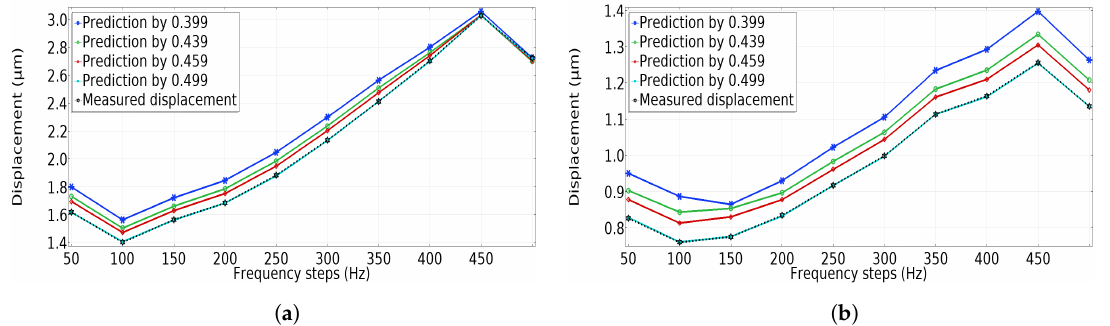
Figure 15. Displacement amplitude versus different Poisson’s ratios in the two boundary conditions; ( a ) connected pipette; ( b ) pipette with